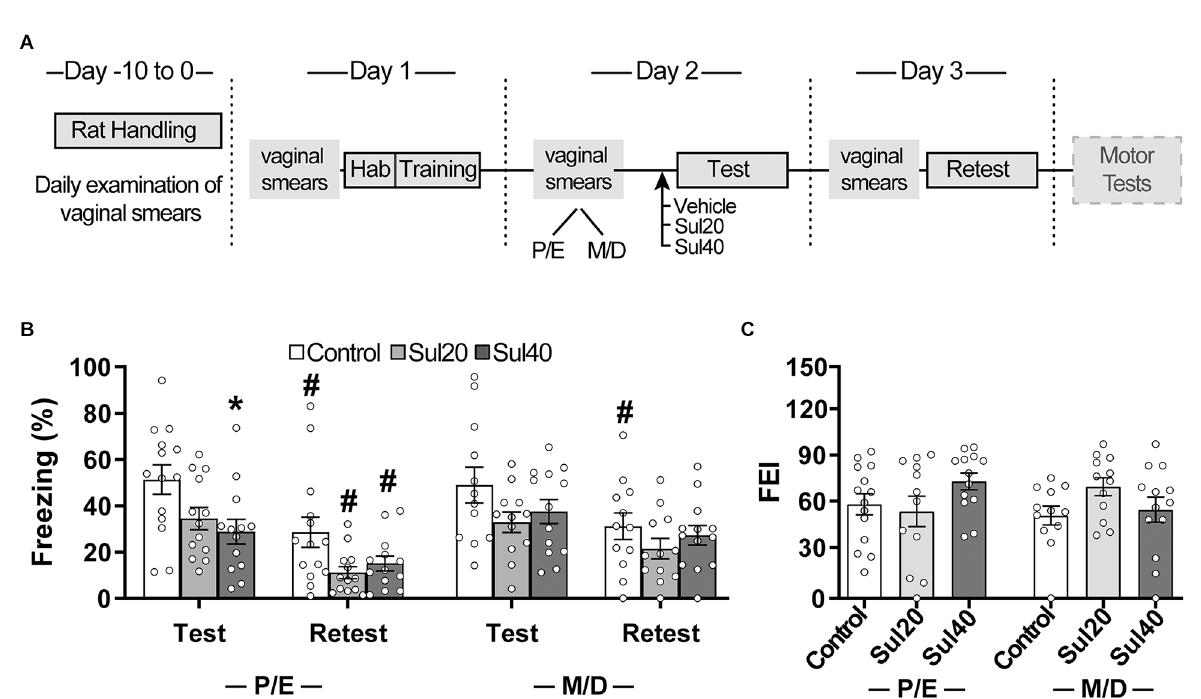
FIGURE2 Sulpiride decreased the expression of conditioned freezing in female rats. (A) Timeline of the experimental procedure. (B) Effects of sulpiride 20 and 40 mg/kg on the expression (test) and extinction (retest) of contextual conditioned freezing in female rats in proestrus/estrus (P/E) and metestrus/diestrus (M/D). Mean percentage of freezing during test and retest sessions (time spent freezing during session/session duration*100). (C) Fear extinction index (FEI; % freezing exhibited during the final block of the training session − % freezing exhibited during retest session). * p < 0.05: different from the control group in the same session; # p < 0.05: different from the same group during the test session. Females P/E: n = 14 for Control, 12 for Sul20, 13 for Sul40; Females M/D: n = 12 for Control, 12 for Sul20, 13 for